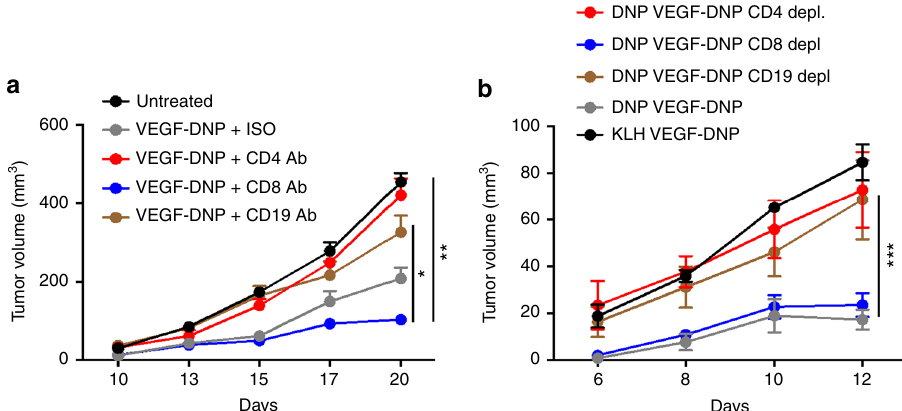
Fig. 5 Role of immune subsets in VEGF – DNP conjugate-mediated tumor inhibition. a DNP immune mice were implanted subcutaneously with 4T1 tumors and treated with VEGF – DNP conjugates as described in Fig. 2. As indicated, mice were treated with depleting anti-CD4, anti-CD8, anti-CD19 and isotype control antibodies, and monitored for tumor growth. CD4 Ab versus isotype control, ** p = 0.006; CD19 Ab versus isotype Ab, * p = 0.022, Student ’ s t -test. (7 mice per group) ( n = 2). b Splenocytes from DNP immune (DNP) mice shown in a and from mock immunized mice (KLH) treated with VEGF – DNP were transferred to naive Balb/c mice, challenged with 4T1 tumor subcutaneously and tumor growth was measured. CD8 depletion versus KLH + VEGF – DNP, *** p = 0.0002, Student ’ s t -test. (7 mice per group) ( n = 2). Data are represented as mean ±